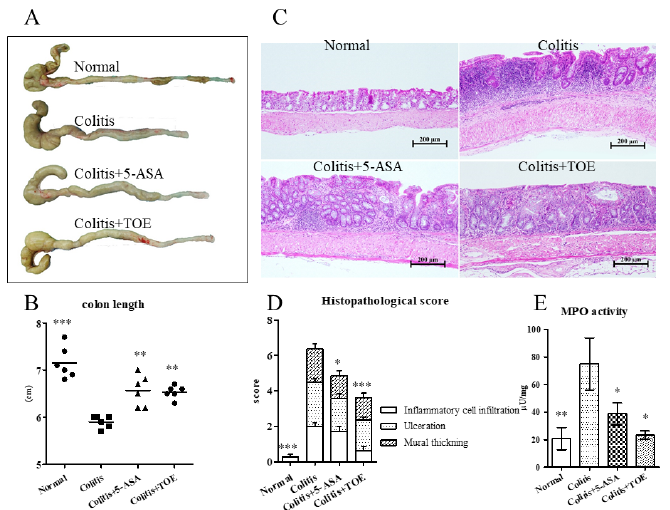
Figure 6. Effect of M2 fraction of Turbinaria ornata extract (TOE) on gross and microscopic examination of DSS ‐ induced chronic colitis in C57BL/6 mice. ( A ) Gross lesions of colitis. ( B ) Colon length. ( C ) Microscopic examinations of hematoxylin and eosin (H&E) stained colon tissues ( × 10 magnification, bar = 200 µ m). ( D ) Histopathological scores of colitis. ( E ) Myeloperoxidase (MPO) activity of colon tissue lysates. * p < 0.05, ** p < 0.01, *** p < 0.001, compared with the colitis group. Normal, DSS- / D.W; colitis, DSS + / D.W, colitis + 5-ASA, DSS + / 5-ASA 50 mg per kg; colitis + TOE, DSS + / TOE 15 mg per